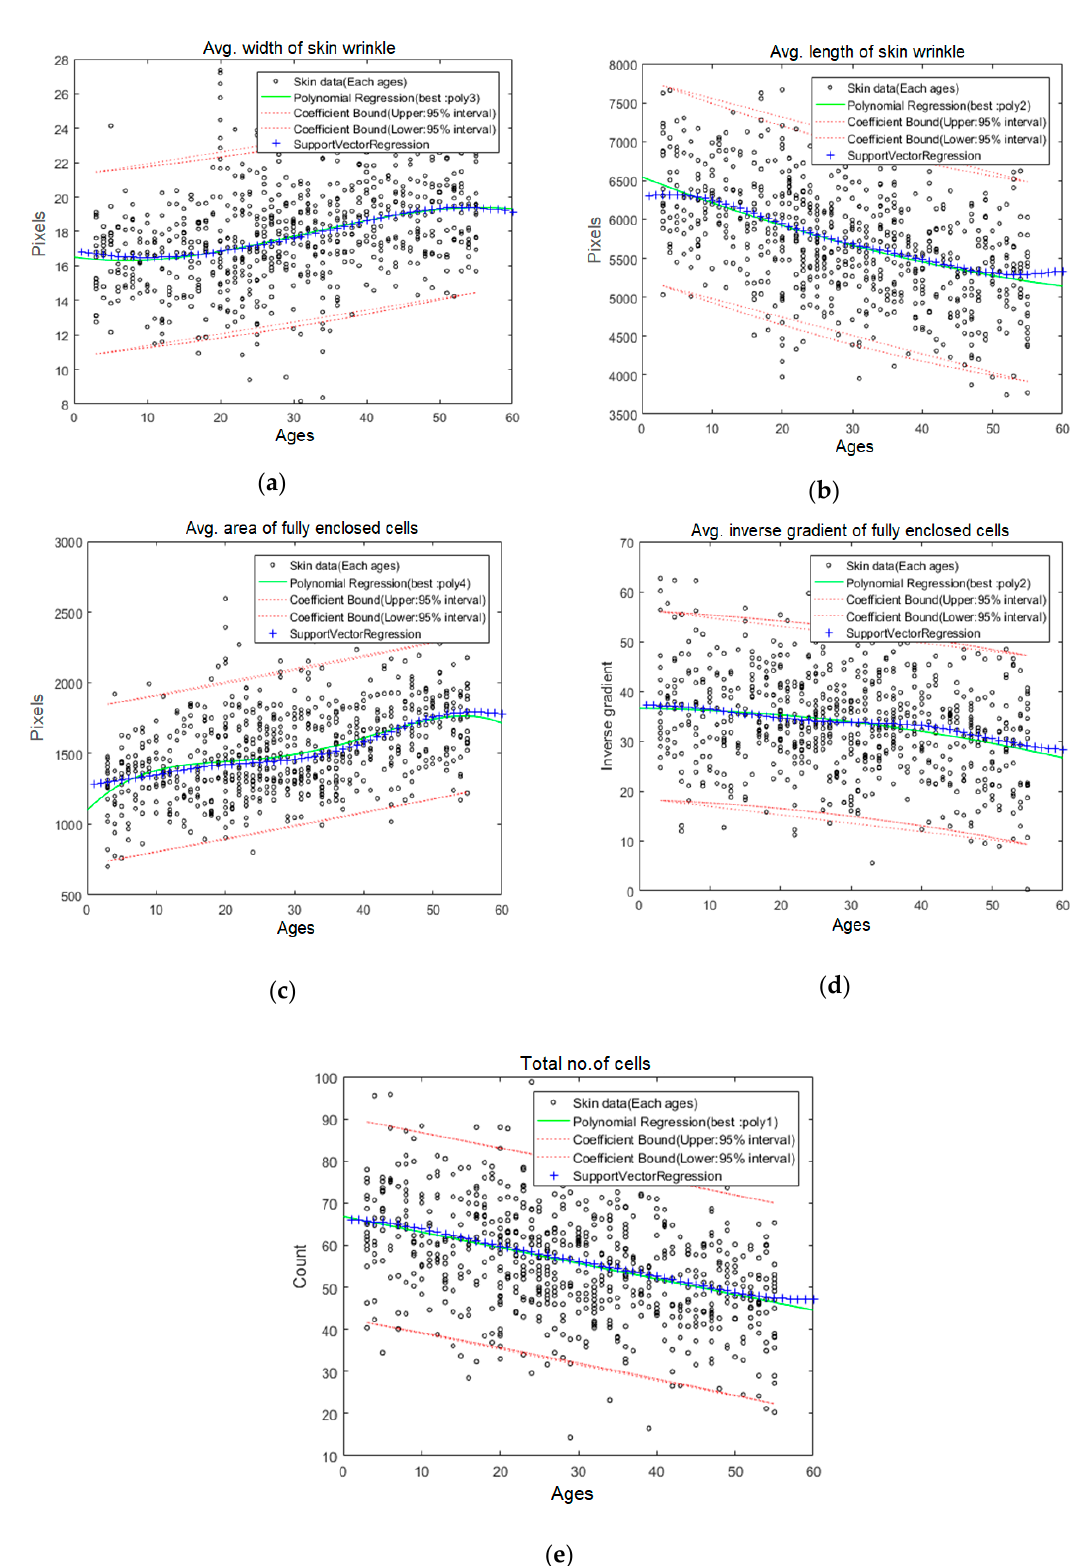
Figure 14. Hand skin texture aging trend estimation using polynomial regression and SVR—( a ) average width trend of hand wrinkle; ( b ) average length trend of hand wrinkle; ( c ) average area trend of fully enclosed hand cells; ( d ) average inverse gradient trend of fully enclosed hand cells; (e) trend of the total number of hand cells .